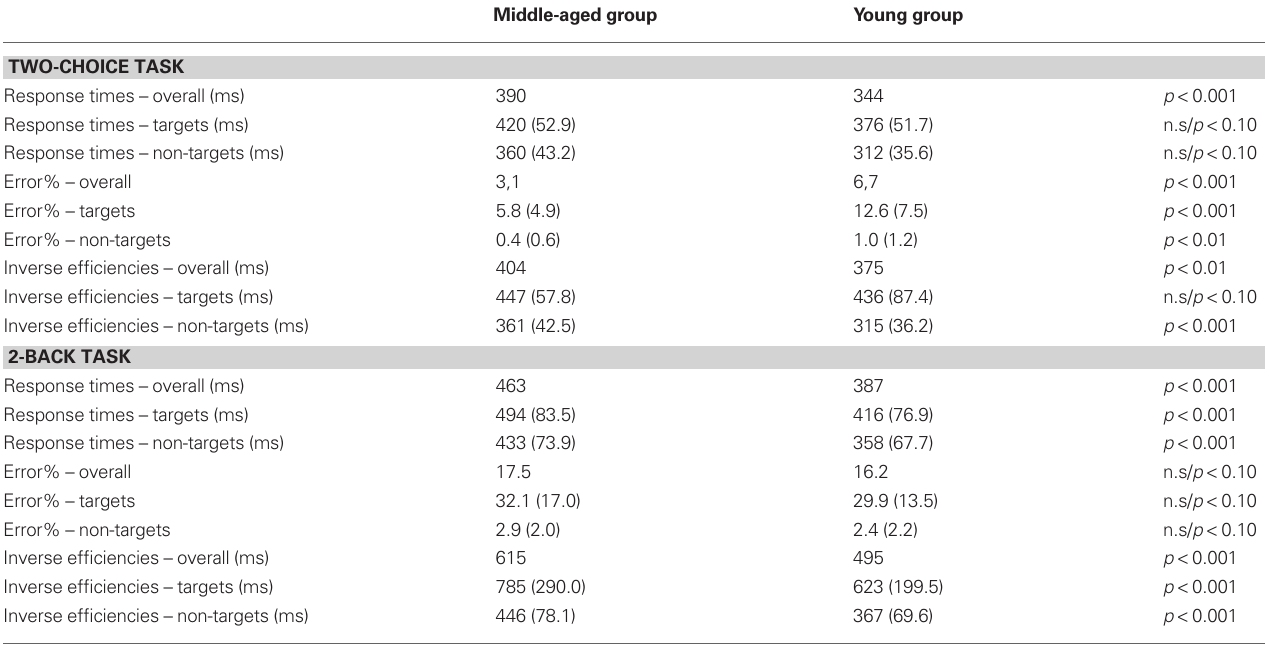
Table 1 | Performance data of the middle-aged and the young group in the two-choice task (upper panel) and the 2-back task (lower